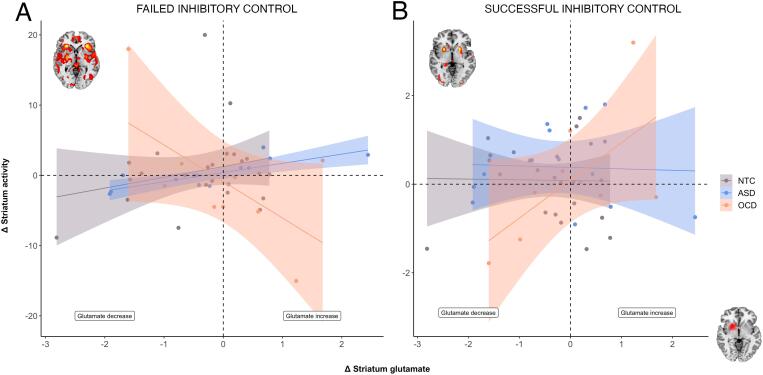
Failed and Successful inhibitory control. A: During failed inhibitory control, an increase in striatal glutamate (i.u.) was associated with a decrease in striatal BOLD signal in the OCD (N = 9) group (salmon) compared to controls (N = 24) (grey) and ASD (N = 13) (blue). B: During successful inhibitory control, an increase in striatal glutamate (i.u.) was associated with an increase in striatal BOLD in the OCD group compared to controls and ASD. Brain activity is shown on the axial slice for both failed and successful inhibitory control outlining the striatal voxel as an overlay. Activity is presented at p < 0.01 (uncorrected) for visualization purposes. The shaded areas represent the 95% confidence intervals. Note: This figure shows raw data-points, not model estimates. (For interpretation of the references to colour in this figure legend, the reader is referred to the web version of this article.)